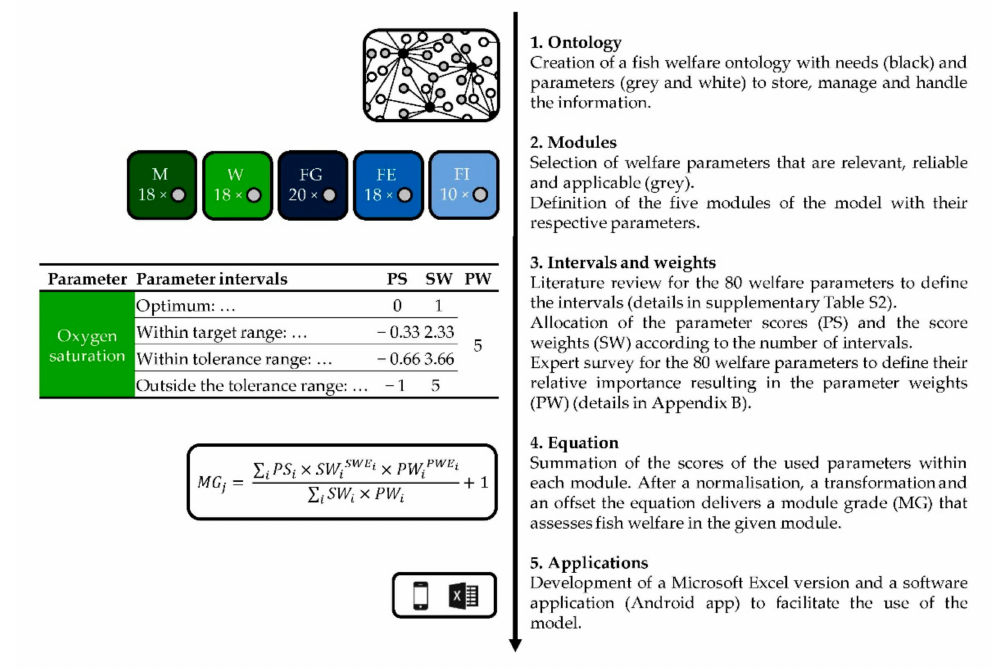
Figure 1. Flow chart of the model development process. M (dark green) = module farm management, W (light green) = module water quality, FG (dark blue) = module fish group behaviour, FE (blue) = module fish external appearance, FI (light blue) = module fish internal appearance, SWE = score weight exponent, PWE = parameter weight exponent. Table 1. Fish welfare needs, adapted from [32,42,44], representing function-based, feelings-based and nature-based aspects of welfare. If these needs are met the fish is assumed to experience good welfare. Need A Fish Needs to be . .